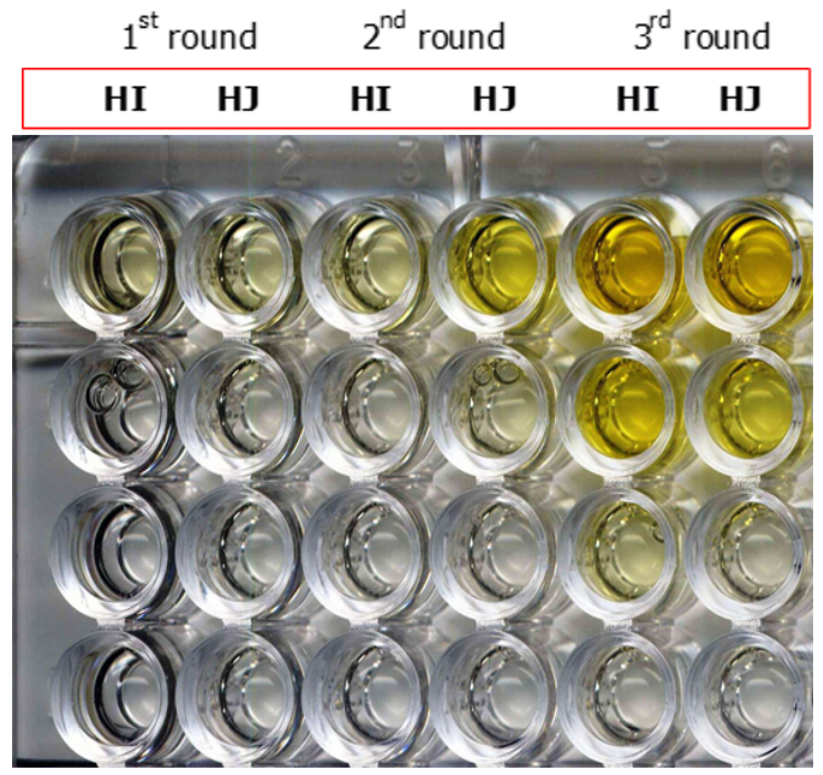
Figure 3. Polyclonal phage ELISA of phage selected in successive rounds of panning against fraction F3. Results from selections from library I (HI) and J (HJ) are shown. The rounds of selection are as designated on the top of the image. Overnight coating of F3 (30 µg/mL). Around 10 13 phages into the first well of each column, then 10-fold dilution down the plate. Adding anti-M13/HRP to detect binding of virus to the target. TMB was added as substrate for HRP. Reactions were stopped with sulfuric acid